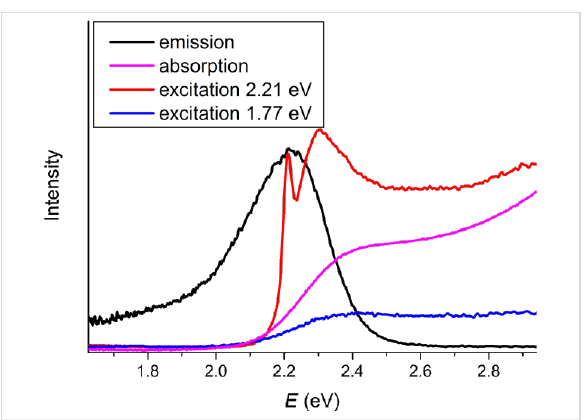
that the Zn levels are pinned in the band gap when the size of the QDs changes. The valence band energy of bulk InP is set to zero. The quantum confinement effect takes place when the size of the particle is less than the exciton Bohr radius [23].